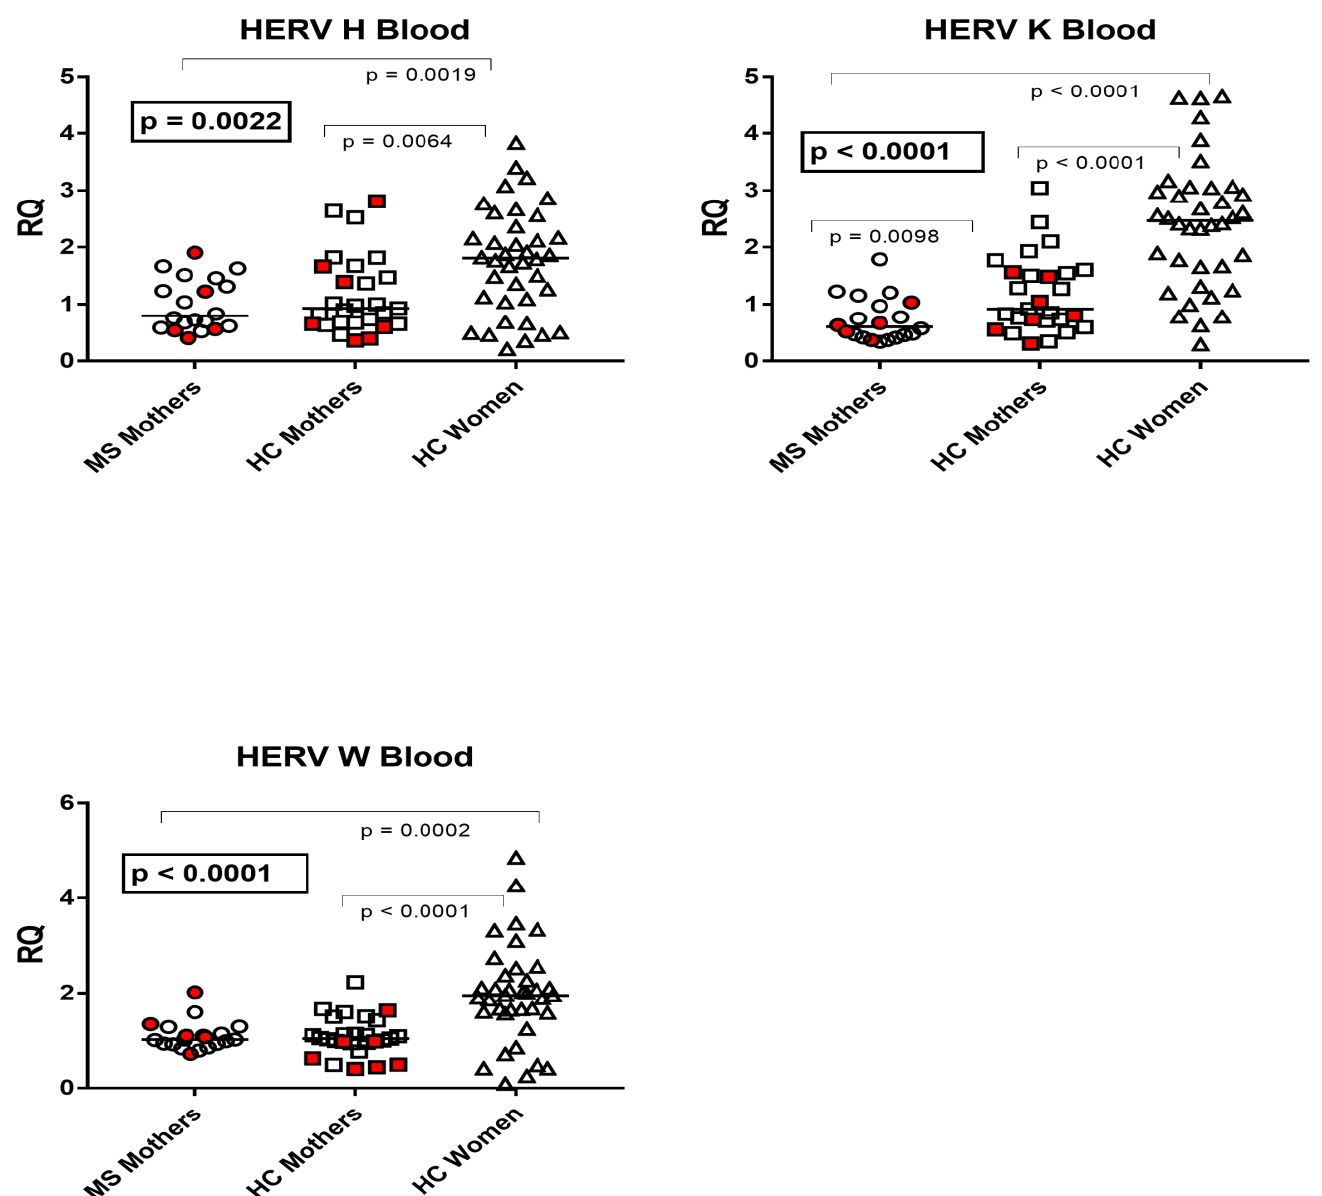
Figure 1. Expression of pol genes of HERV-H, -K, and -W in peripheral blood from 20 mothers with multiple sclerosis (MS), 27 healthy control (HC) mothers, and 38 nonpregnant healthy women of child-bearing age. RQ: relative quantification. Circles, squares, and triangles show the mean of three individual measurements; horizontal lines show the median values. Premature deliveries are in red. Medians and IQR 25 – 75%: HERV-H- pol : Group A (mothers with MS) 0.80, 0.61 – 1.35; Group B (unaffected mothers) 0.93, 0.66 – 1.60; Group C1 (nonpregnant women) 1.81, 1.10 – 2.32; HERV-K- pol : Group A 0.60, 0.45 – 0.99; Group B 0.92, 0.72 – 1.56; Group C1 2.47, 1.66 – 3.03; HERV-W- pol : Group A 1.02, IQR 0.92 – 1.78; Group B 1.04, 0.95 – 1.28; Group C1 1.95, 1.59 – 2.35.